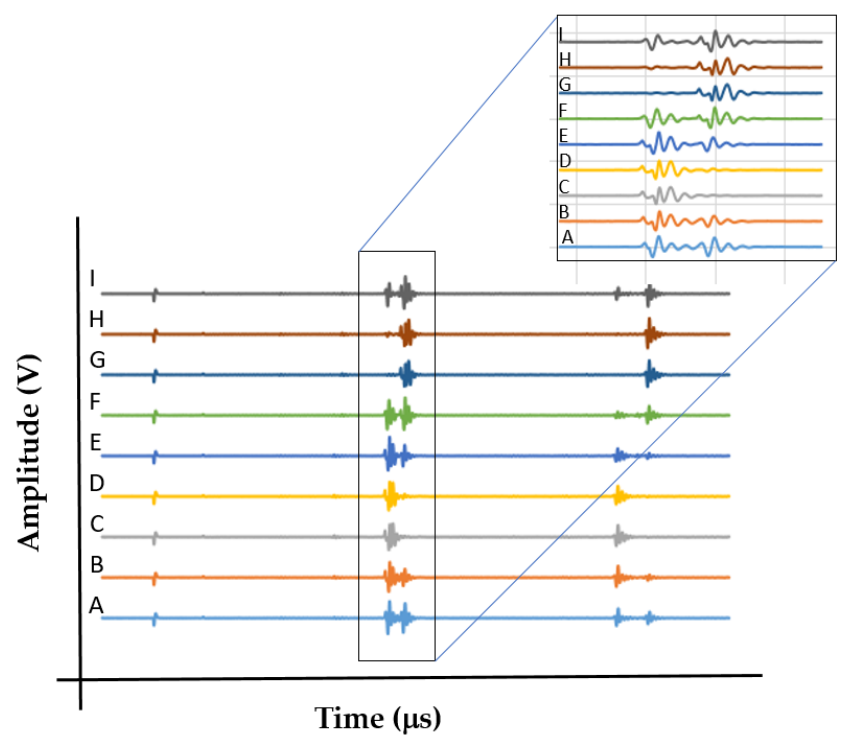
Figure 9. Nine shear sound waves at different angles (A–I) in the wrought alloy sample. The first and second echoes are evident. The zoom-in reveals the appearance and disappearance of the first and second reflection waves.